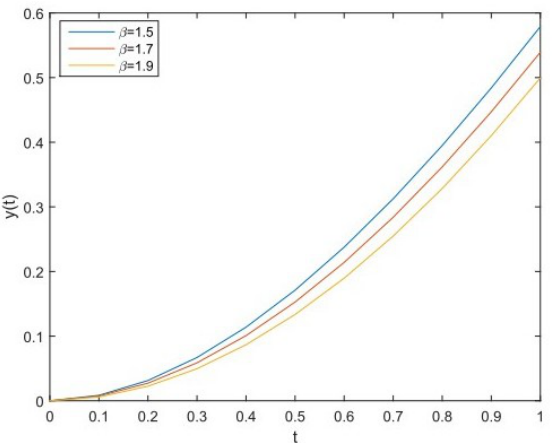
Figure 4. Dynamics of an oscillatory pendulum with fractional damping (Fixed α )